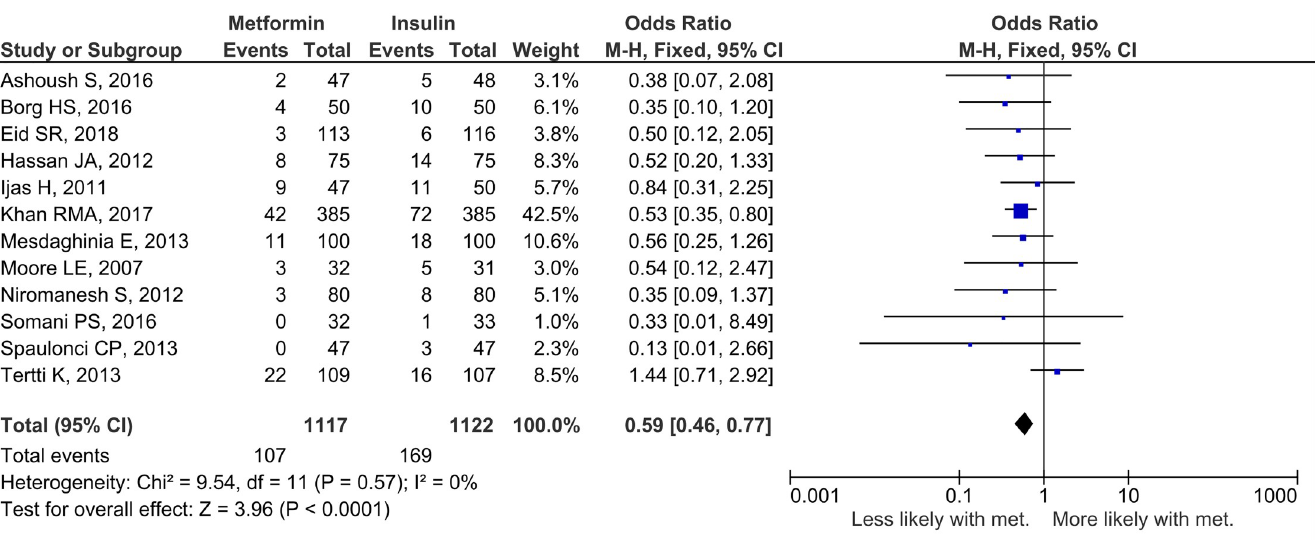
PLOS Medicine| https://doi.org/10.1371/journal.pmed.1002848 August 6,